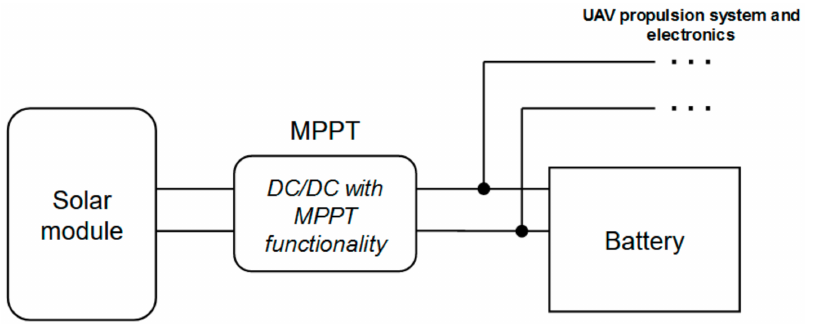
Figure 7. Simplified schematic of the UAV power supply system with the solar module and MPPT included. The output of the MPPT is connected in parallel to the battery, UAV propulsion system and main electronic power supply